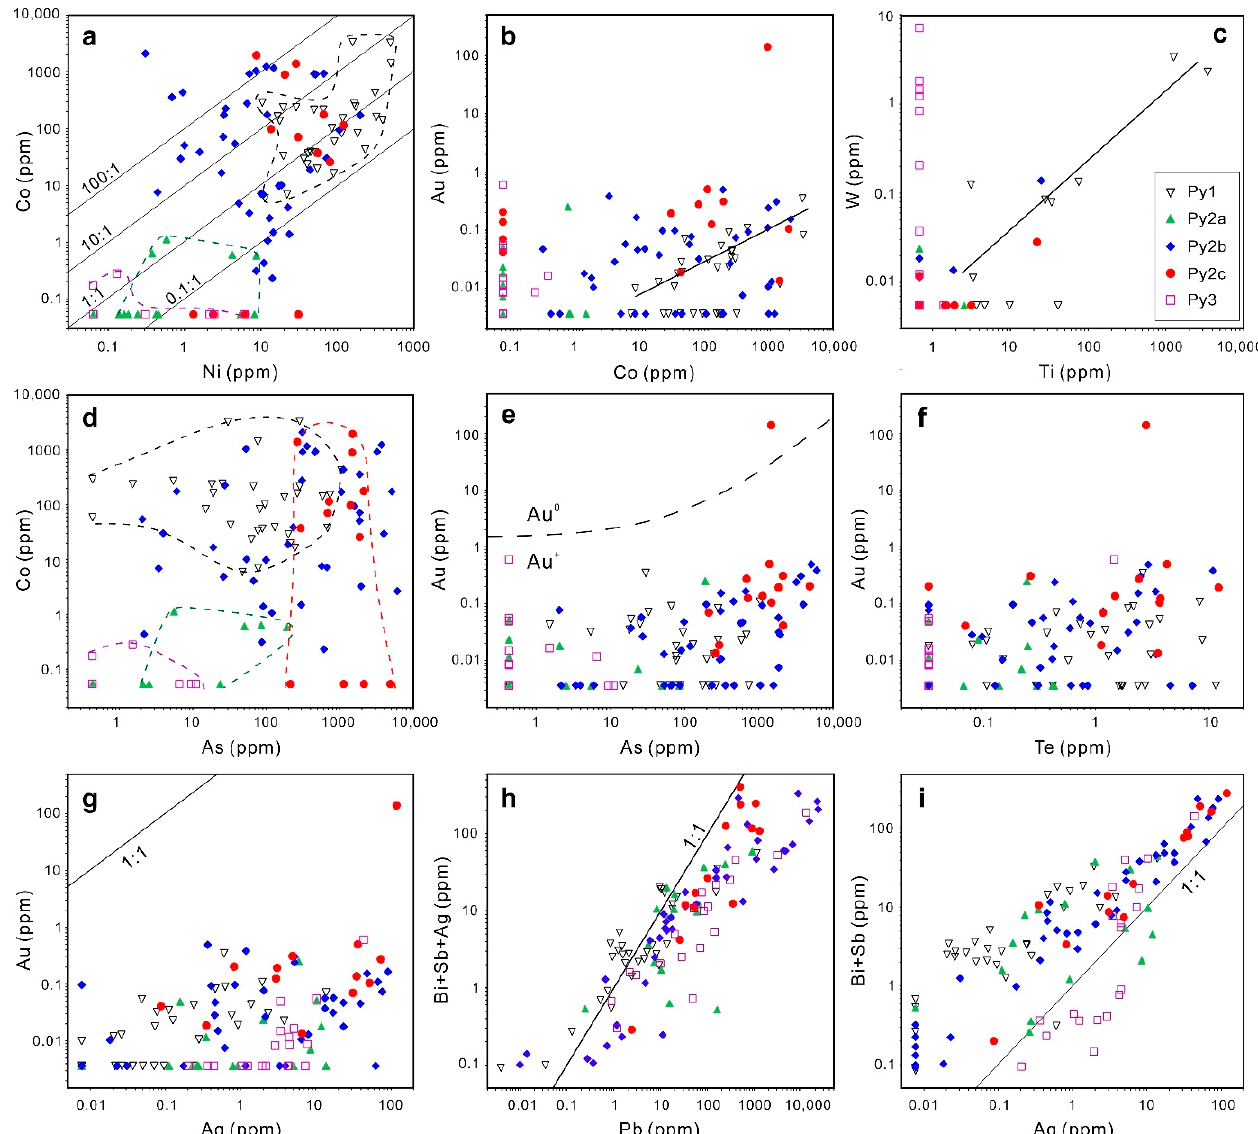
Figure 8. Binary plots of trace elements of the Sizhuang pyrite measured by LA–ICP–MS. ( a ) Ni vs. Co. ( b ) Co vs. Au. ( c ) Ti vs. W. ( d ) As vs. Co. ( e ) As vs. Au. ( f ) Te vs. Au. ( g ) Ag vs. Au. ( h ) Pb vs. Bi + Sb + Ag. ( i ) Ag vs. Bi + Sb. The dashed curve in e represents the solubility limit of Au as a function of As content determined by [59]. Note the legends in 8c are available for all subfigures.